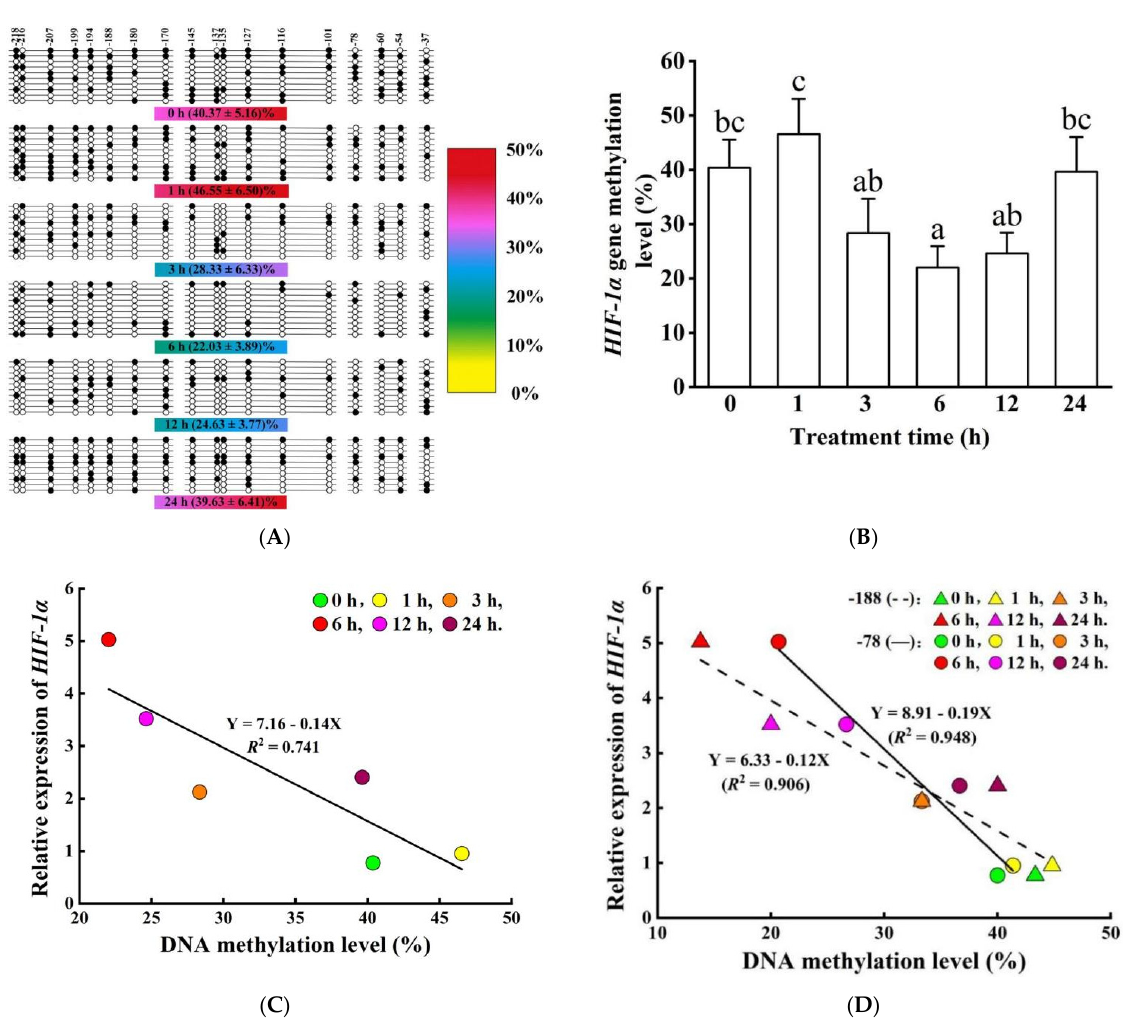
Figure 11. HIF-1 α gene DNA methylation level and its correlation with expression. ( A ) The methylation status of the HIF-1 α gene. The methylation status is represented by circles, in which filled circles show methylation and open circles represent unmethylation. The numbers above circles are the CpG dinucleotides’ locations relative to the start codon, and the percentages under the circles mean average methylation level (M ± SE) in corresponding hypoxia treatment groups. The same below (Figure